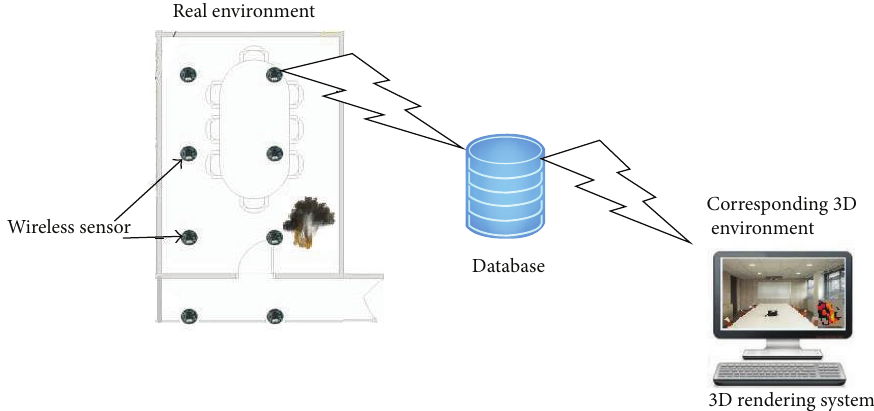
Figure 2: Fire scenario in meeting